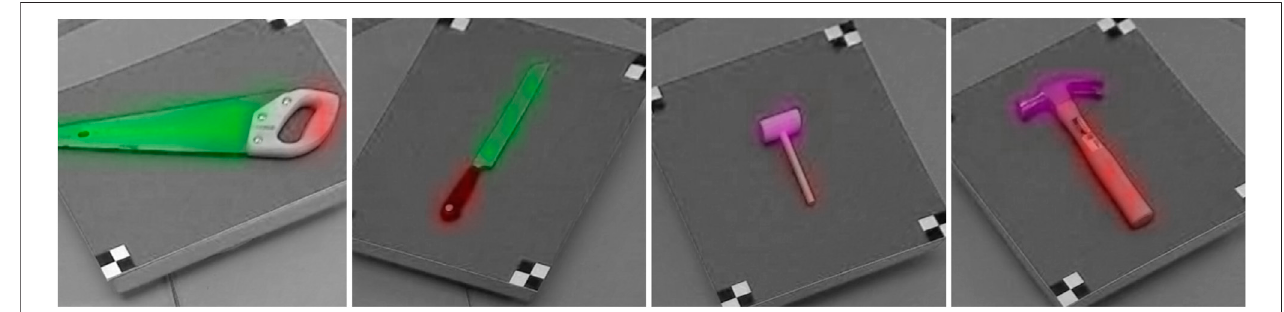
FIGURE1| Affordanceregionsmay bebroad, spanningmultiplepossible tooltips. Asaresult, predicting theaffordance regionisnotsuf fi cienttoplan withrespect to that tool ’ s tooltip. For example, the full blade surfaces of the saw and knife are labeled as enabling the “ cutting ” affordance (highlighted in green) and the “ grasping ” affordance(highlightedinred);however,cuttingisonlyperformedusingtheedgeoftheblade,andrequiresthatthebladebeorientedtowardthecuttingtarget.Similarly, differentpointsofahammerheadmayenabledifferenttasks(e.g.,poundingversusprying),andthusdetectingatask-independentaffordanceregion(highlightedin purple) is not suf fi cient to plan a task